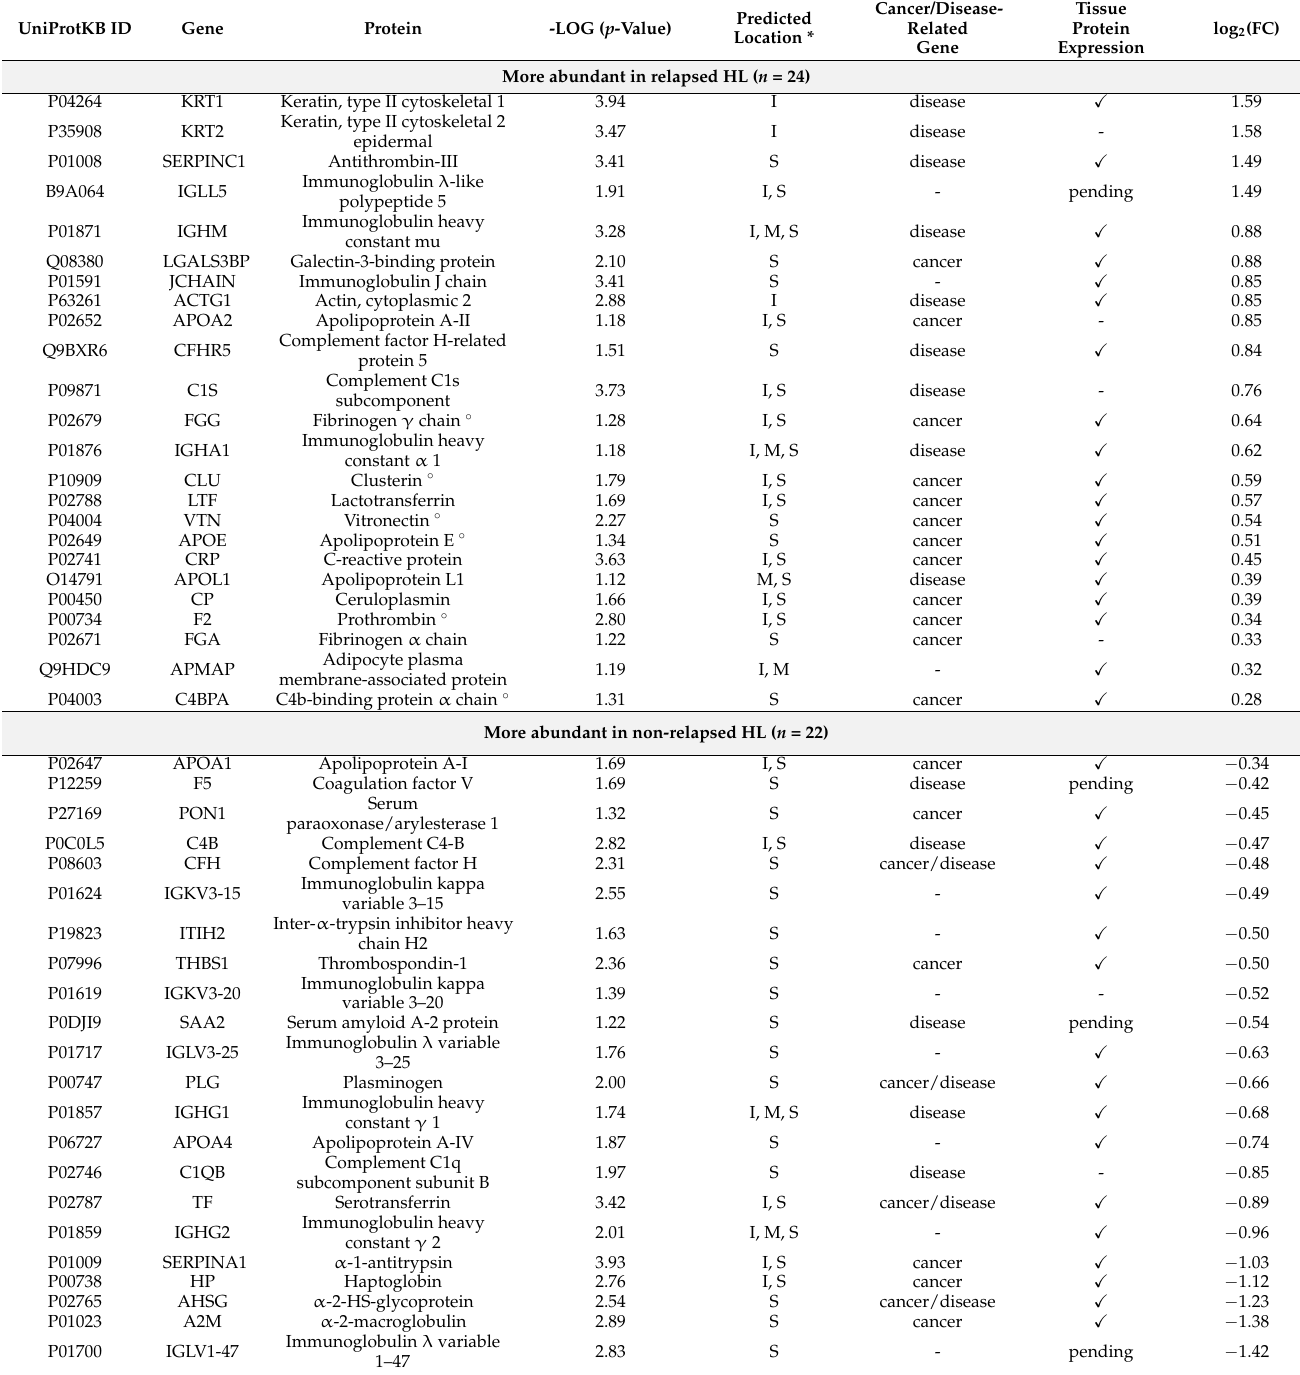
Table 2. Differences in the abundance of proteins in the plasma of patients by HL status (relapsed vs. non-relapsed) in the exploratory cohort ( p <